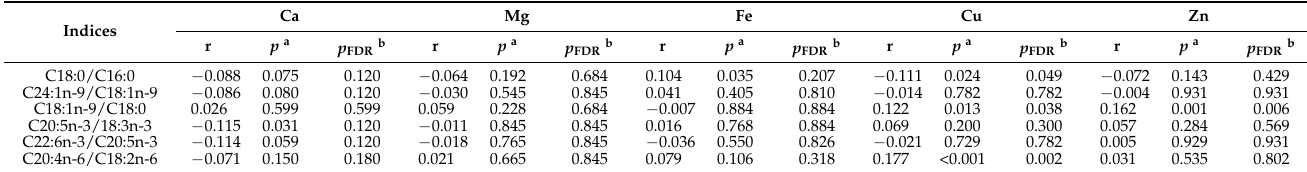
Table 5. Partial correlation coefficients of mineral elements with several indices of desaturases and elongases in erythrocyte among